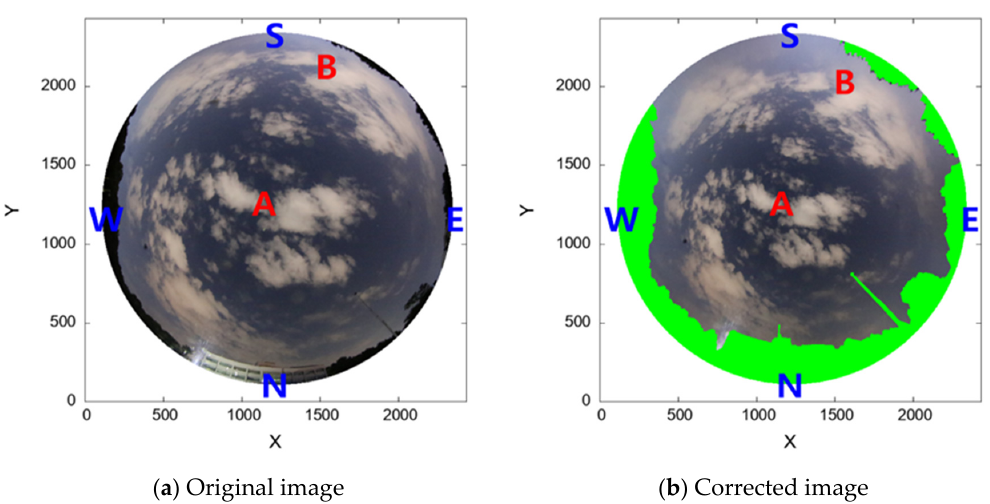
Figure 2. Images (2100 LST, 23 June 2019) before ( a ) and after ( b ) obstacle (green area) and distortion correction.